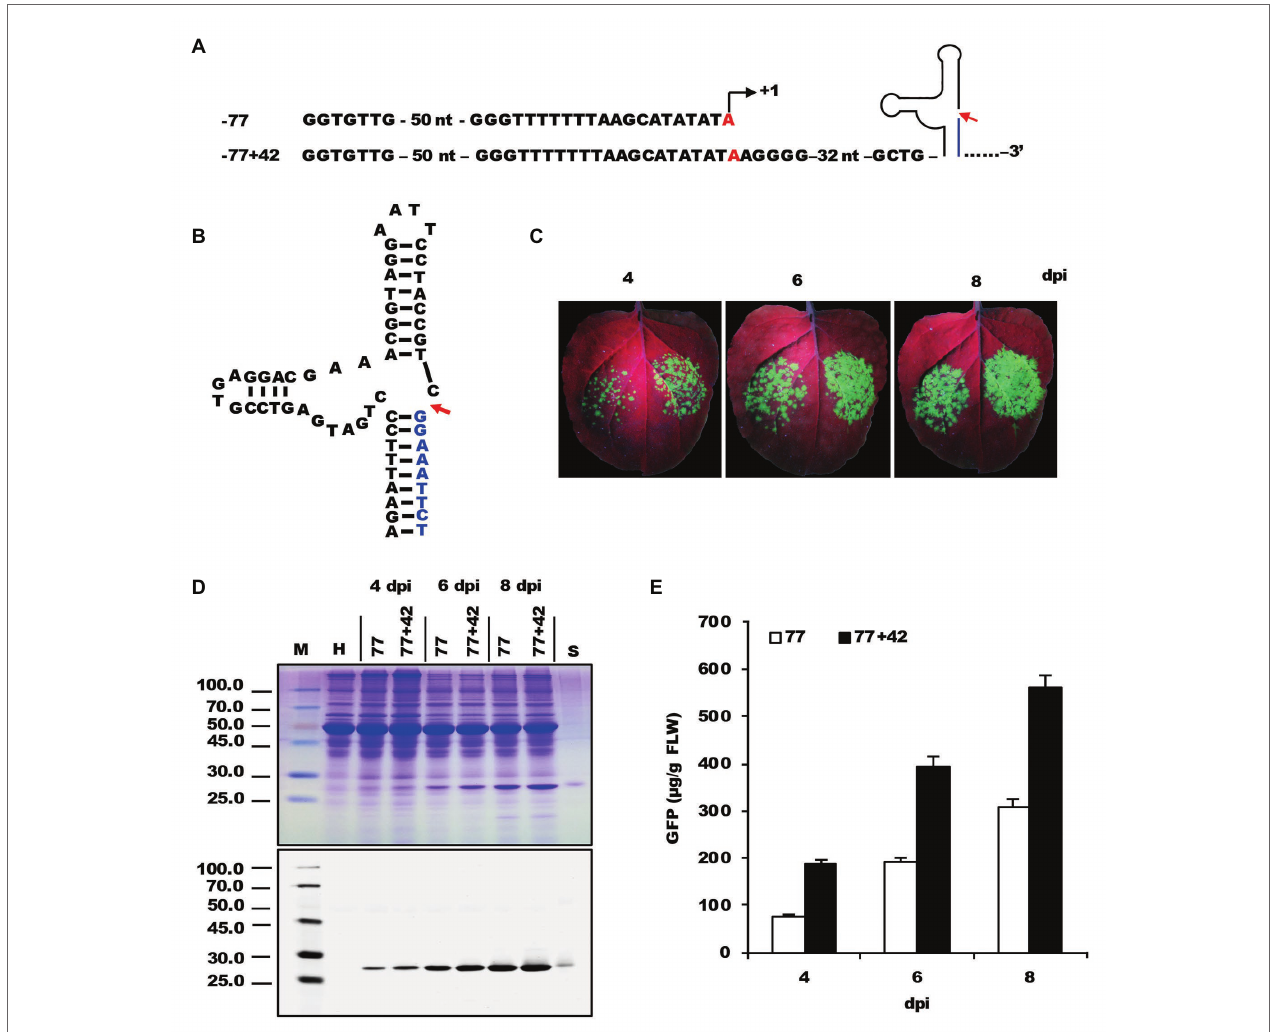
FIGURE 2 | Testing the effect of the sequence downstream of transcription start site on the expression of recombinant proteins. (A) The nucleic acid sequences of mini Nb rRNA gene promoter ( − 77) and its analog with downstream extension sequences and a ribozyme sequence. (B) The nucleic acid sequences and structure of the hammerhead ribozyme. (C) GFP expression pattern (under UV light) of agroinfiltrated N. benthamiana leaves at 4, 6, and 8 dpi, respectively. The left side of the leaf was agroinfiltrated with a − 77 vector and the right side was − 77+42. (D) SDS-PAGE analysis and immunodetection of proteins isolated from the agroinfiltrated zones of N. benthamiana leaves. The gel was stained with Coomassie brilliant blue (upper panel) and the corresponding antibodies were used to detect GFP (lower panel) in agroinfiltrated N. benthamiana leaves by Western blots. M, molecular weight marker (kDa); H, total soluble protein extracts from uninoculated leaves; 77 and 77+42, total soluble protein extracts from the corresponding agroinfiltrated zones of N. benthamiana leaves in (C) . (E) Time course for the accumulation of recombinant GFP protein in N. benthamiana leaves by